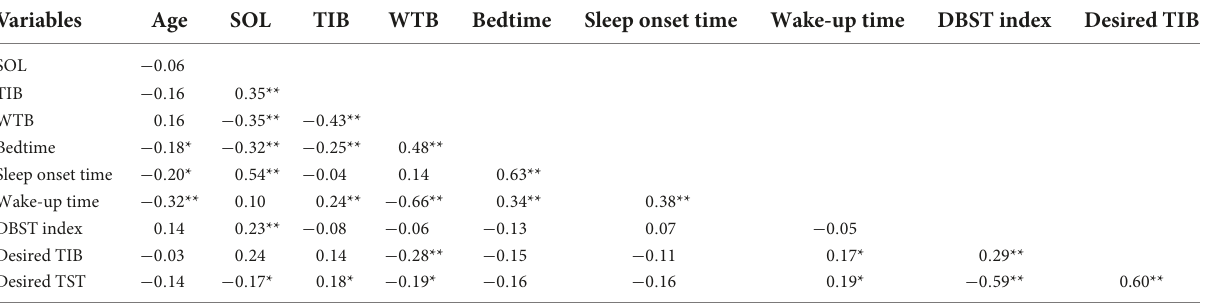
TABLE 3 Correlation coefficients of the DBST index and time/duration variables among patients with cancer ( n = 146). Variables